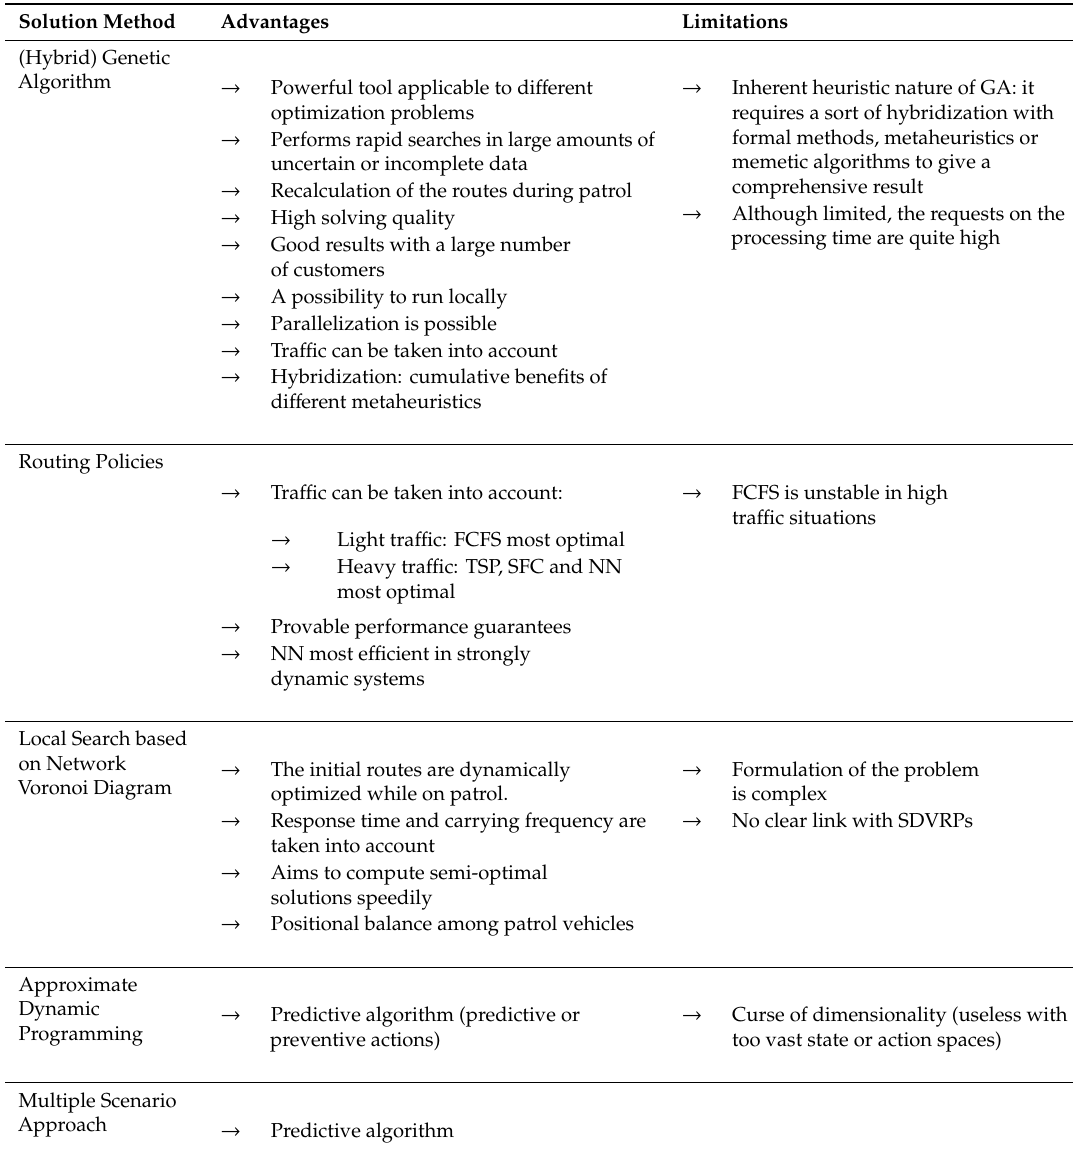
Table 2. Advantages and limitations of the most convenient solution methods for the police patrol routing problem